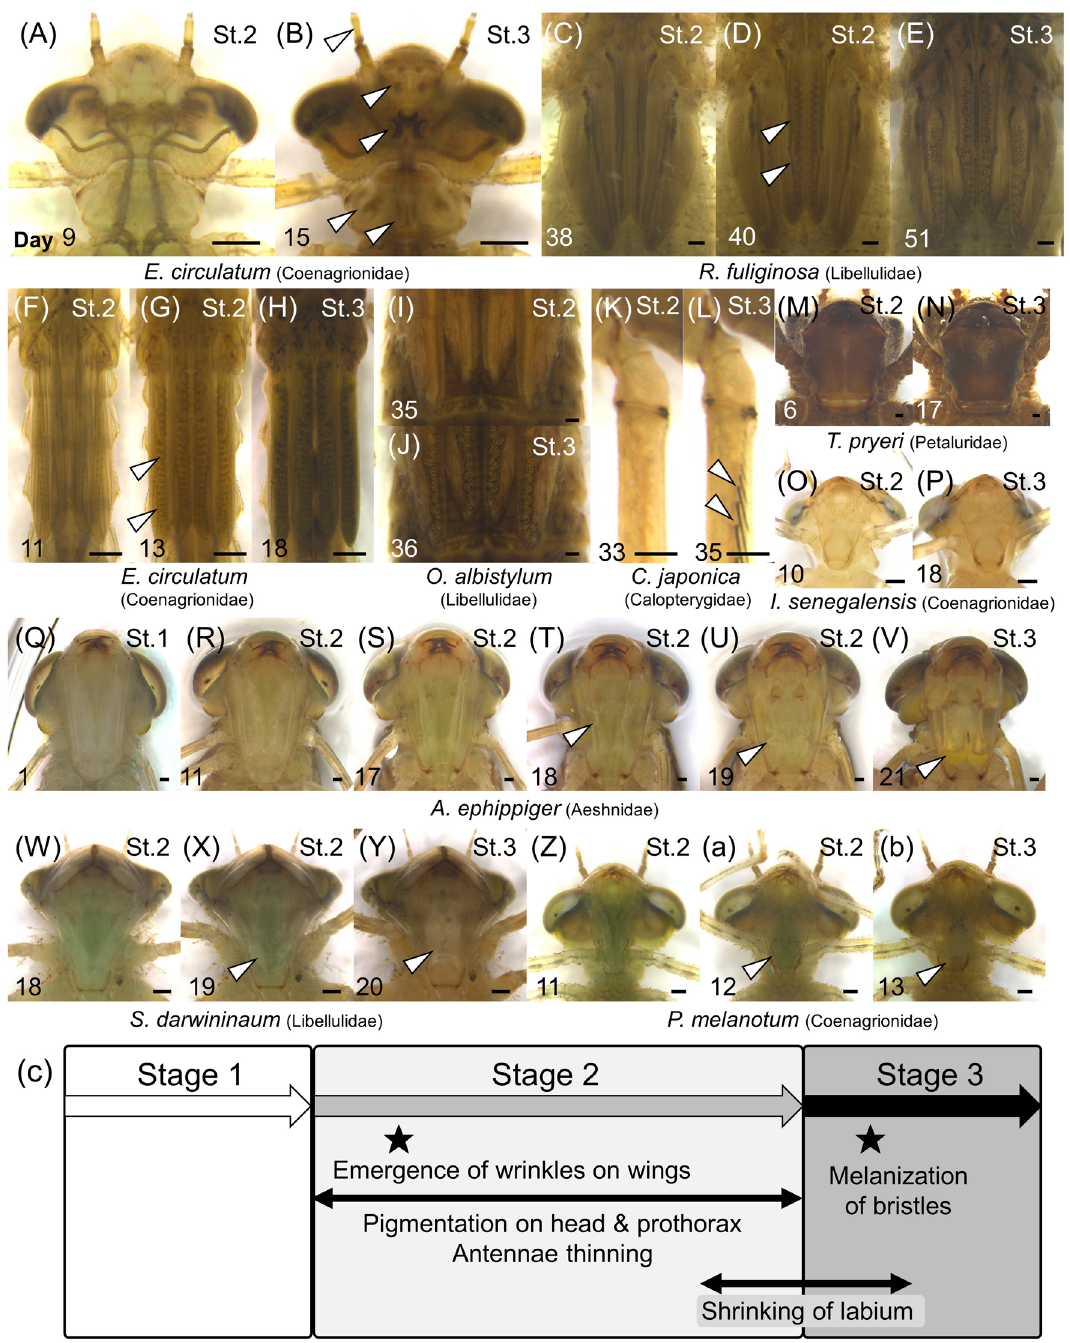
Figure 7. Morphological changes other than compound eyes during F−0 larval instar. The number on each photo indicates the number of days after ecdysis or starting photographing. All scale bars show 0.5 mm. Species and family names are indicated at the bottom. Developmental stage is shown on the upper right of each photo. ( A , B ) Dorsal views of the heads. White arrowheads indicate specific pigmentation that appeared during stage 2. ( C – J ) Magnified views of wing sheaths. White arrowheads indicate wrinkles in the wing sheaths. ( C , F ) The first day of stage 2. ( D , G ) The day on which the wrinkles on the wing sheaths appeared. ( E , H ) The first day of stage 3. ( K – L ) Magnified views of right foreleg. White arrowheads indicate melanized bristles. Adult emergence was observed on Day 37. ( M-b ) Ventral views of the heads. White arrowheads indicate the degraded larval labia. ( Q ) The first day of stage 1. ( M , O , R ). The first day of stage 2. ( T , W , Z ) Two days before the onset of stage 3. ( U , X , a ) One day before the onset of stage 3. ( Y , b ) The first day of stage 3. ( N , P , V ) The last day of stage 3. ( c ) Schematic diagrams on the timing of the morphological changes during F−0 larval